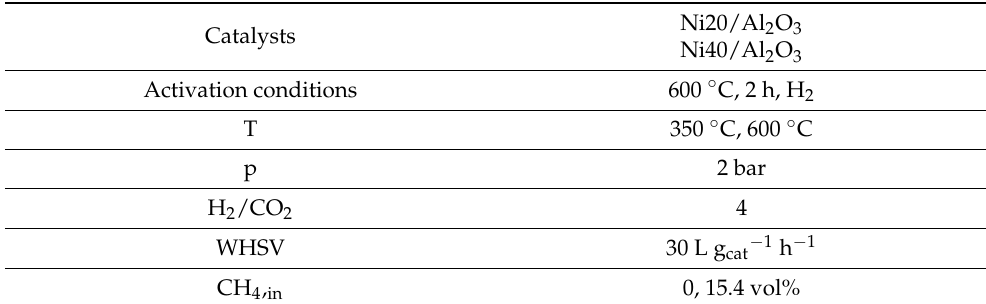
Table 7. Catalyst and reaction conditions for fixed-bed reactor experiments on CH 4 influence on methanation over unpromoted Ni/Al 2 O 3